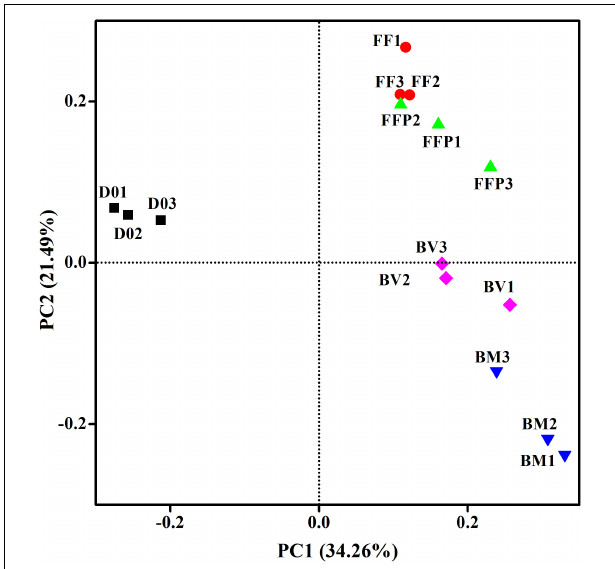
FIGURE 7 | Principal coordinates analysis (PCoA) of microbial communities in initial soil samples and propionate-fed samples based on the weighed UniFrac distance (D01-D03: triplicates of initial soil sample; FF1–FF3: triplicates of ferrihydrite-free cultures; FFP1–FFP3: triplicates of ferrihydrite-free + P cultures; BM1–BM3: triplicates of biogenic-magnetite cultures; and BV1–BV3: triplicates of biogenic-vivianite cultures).